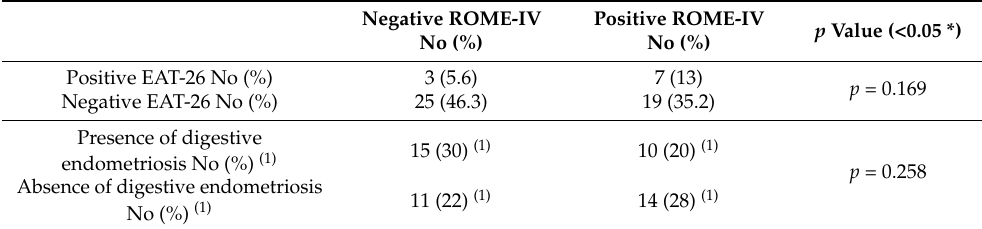
Table 3. ROME-IV score and other variables of interest in the 54 responding patients. EAT-26: Eating Attitudes Test-26; HAD: Hospital Anxiety and Depression Scale; *, p < 0.05.